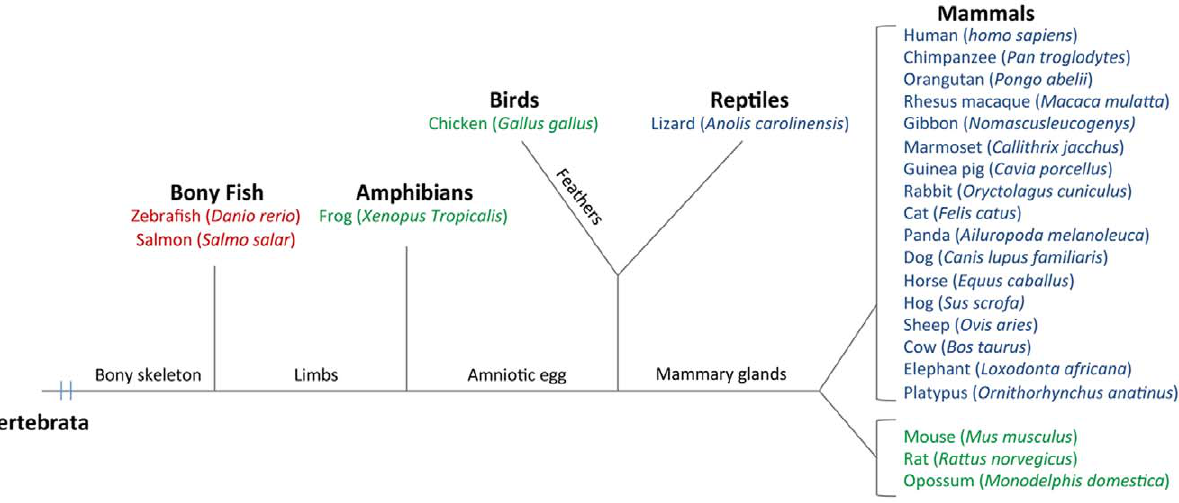
Figure 7. Phylogenetic Relationship of the Cobalamin Binding Proteins TC, HC, and IF. The phylogenetic tree is constructed from nucleotide search using the NCBI- and UCSC genome browser websites in registered vertebrates. Species are colored recording to the findings of one (predicted to be TC-like) (red), two (TC and IF) (green), or three (TC, IF, and HC) (blue) cobalamin binders in the databases. The accessions numbers for the sequences are listed in the supplementary data (Table